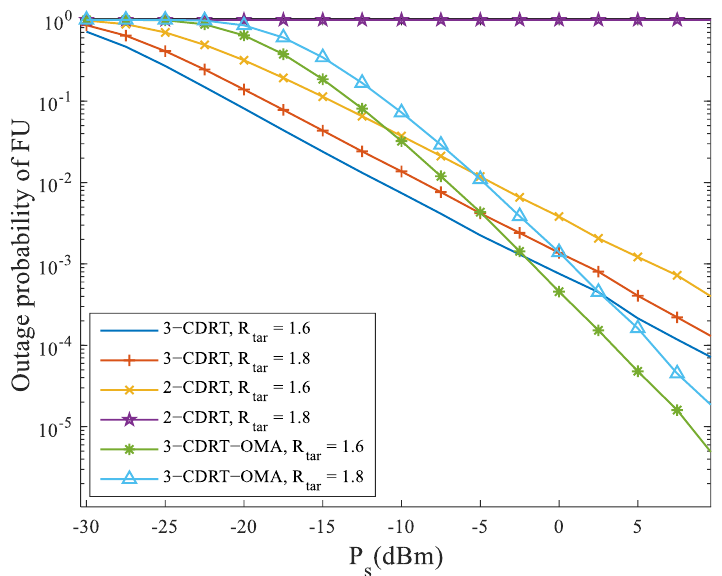
Figure 5. Comparison among the proposed 3 − CDRT strategy, the 2 − CDRT strategy and the 3 − CDRT − OMA strategy in terms of the outage probability of FU with varying P s (dBm).